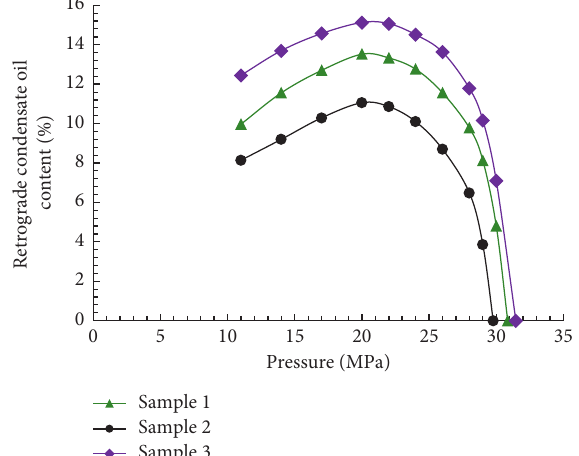
Figure 3: The relationship diagram between retrograde condensed liquid volume and pressure of condensate gas with different CO 2 content.